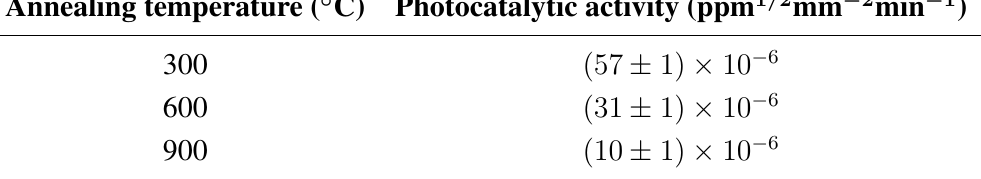
Table 2. Photocatalytic activity at various annealing